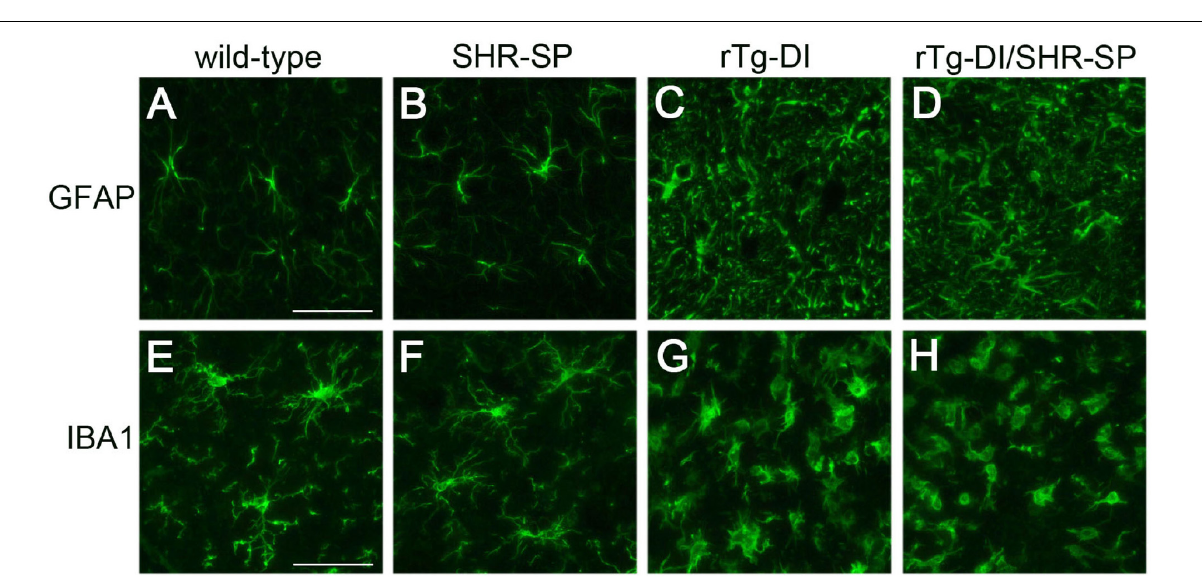
FIGURE 8 | Increased thalamic activated glial cells in 10 M rTg-DI rats and bigenic rTg-DI/SHR-SP rats. Representative images of the thalamus from rat brain sections immunolabeled for GFAP to identify astrocytes (upper panels) and IBA-1 to identify microglia (lower panels). WT rats (A,E) , SHR-SP rats (B,F) , rTg-DI rats (C,G) , and bigenic rTg-DI/SHR-SP rats (D,H) . Scale bars = 50 µ m. Both rTg-DI and bigenic rTg-DI/SHR-SP rats exhibit increased numbers and activation of glial cells in the